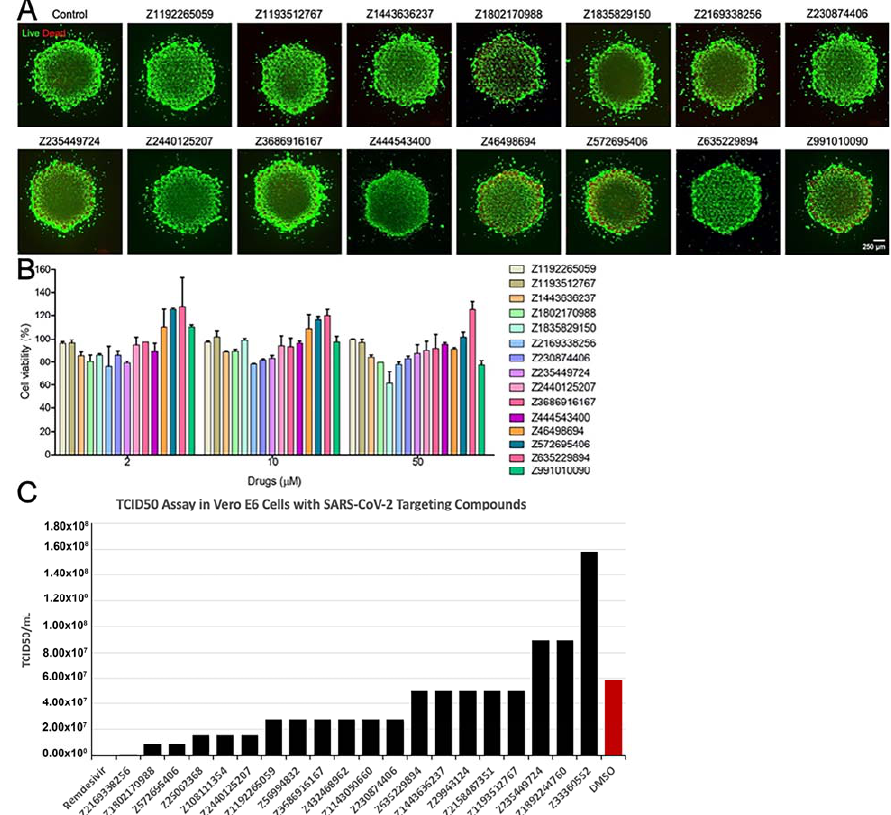
Figure 7. In vitro compound evaluation. ( A ) Fluorescence images showing live (green)/dead (red) staining after 24 h of treatment by the compounds (50 μ M). ( B ) Quantification of cell metabolic activities by the MTS assay after 24 h of treatments by the compounds at different concentrations. ( C ) Quantification of TCID 50 assay in Vero E6 cells when treated with Remdesivir, DMSO, or a SARS ‐ CoV ‐ 2 ‐ targeting compound.